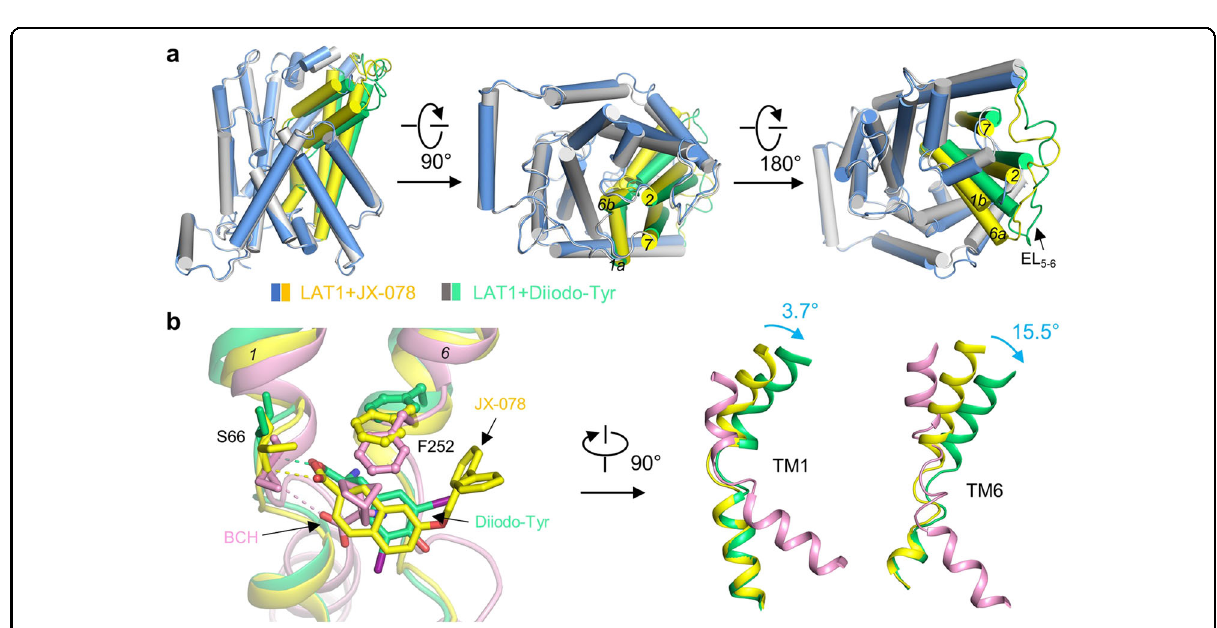
Fig. 5 The asymmetrical movement of TM1 and TM6. a Comparison between the outward-occluded structure of LAT1 bound with JX-078 and that bound with Diiodo-Tyr, with the side view, the bottom view, and the top view shown in left, middle, and right panel, respectively. b Structural comparison among the inward-facing structure of LAT1 bound with BCH and the outward-occluded structure of LAT1 bound with JX-078 or Diiodo-Tyr (left panel). The movement of TM1 and TM6 is shown in the middle and right panel, respectively. BCH, JX-078, and Diiodo-Tyr are colored pink, yellow, and lemon green,